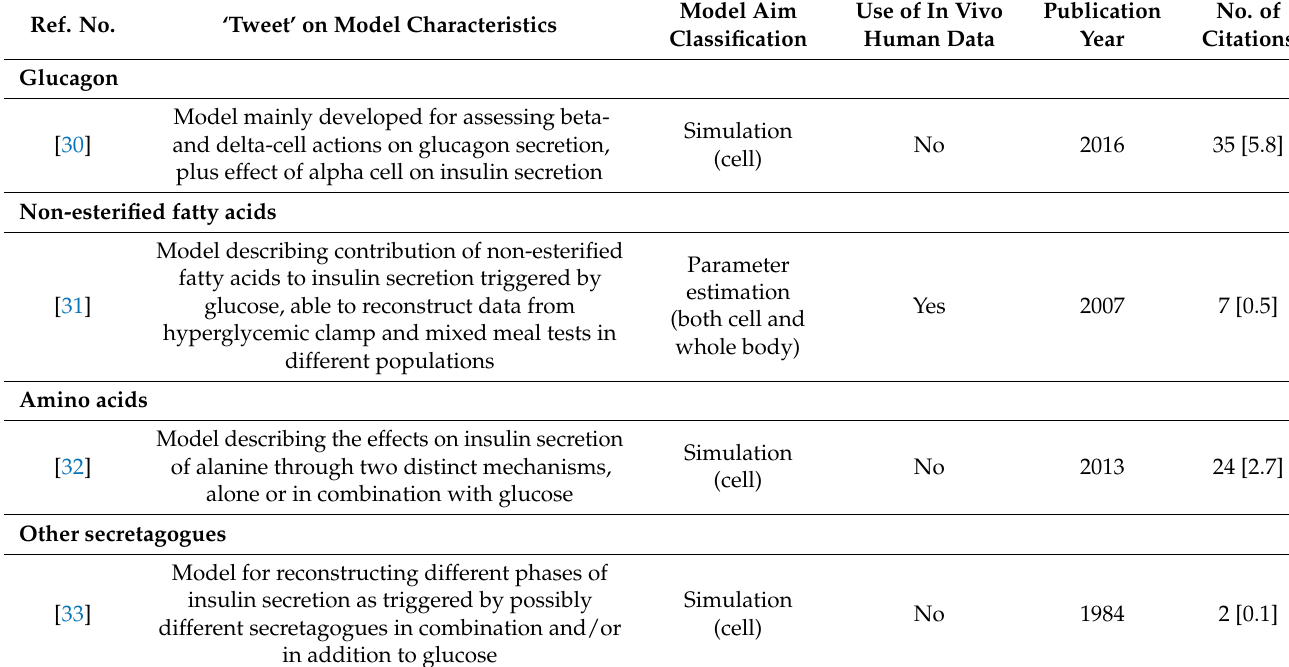
Table 2. Basic information on the models of the effect on insulin secretion and beta-cell function by glucagon, non-esterified fatty acids, amino acids, and other secretagogues. In the “‘Tweet’ on model characteristic” field, a short description ( ≤ 200 characters) on the main model characteristics is reported. In the “Model aim classification” field, either “simulation” or “parameter estimation” is reported (on the individual subject’s data), based on what appears as the main application of the model; model application at the cellular/organ level or whole body is also specified. To provide an indication of each study impact, the number of citations is reported in the “No. of citations” field (both the absolute number and the number per year, in square brackets). Source: Google Scholar (last checked: 31 January